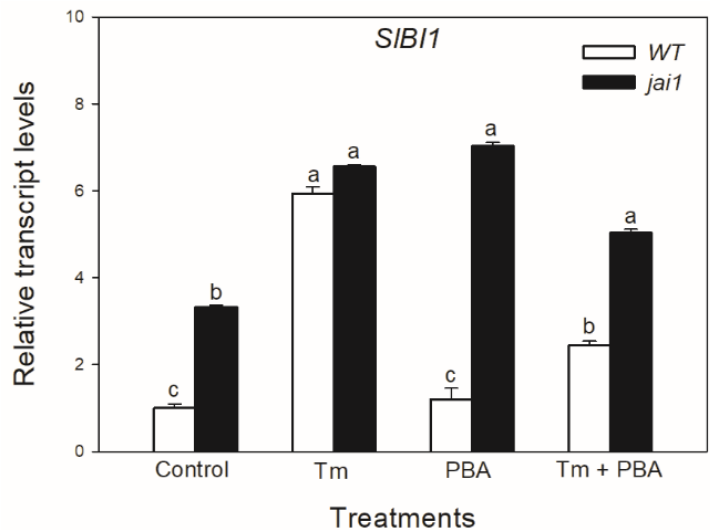
Figure 6. Changes in the transcript accumulation of Bax Inhibitor-1 ( SlBI1 ) in the leaves of wild-type (WT) and JA signalling mutant (jai1) tomato plants exposed to 5 µ g mL − 1 tunicamycin (Tm), 1 mM 4-phenylbutyrate (PBA) and Tm + PBA for 6 h. Results are the means ± SE. Data with different letters indicate significant differences at p < 0.05 level, n = 3.